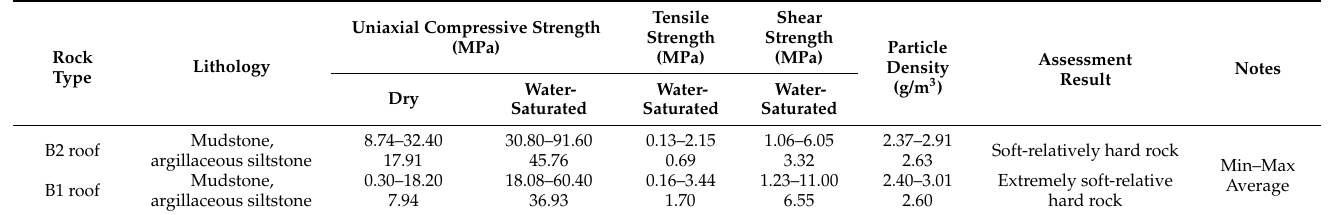
Table 2. The lithology and mechanical properties of the floor and roof of the 1101 working